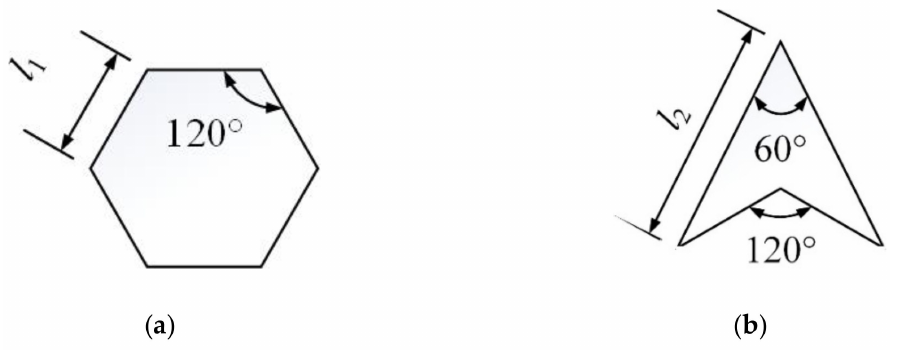
Figure 8. Geometry and dimension of the hexagonal honeycomb and arrow honeycomb: ( a ) hexago- nal honeycomb; and ( b ) arrow